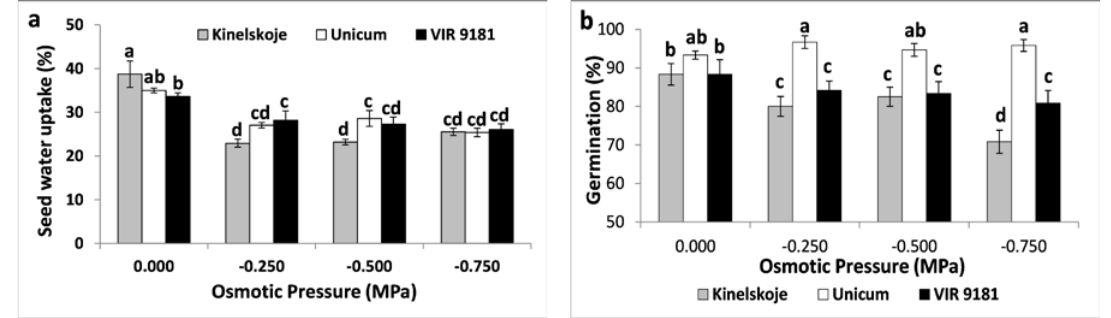
Figure 3. ( a ) Water uptake at 21 h and ( b ) germination percentage at 96 h of millet genotypes under osmotic pressure. Different letters show statistical differences of the treatments at p < 0.05 (Least Significant Difference—Fisher test).